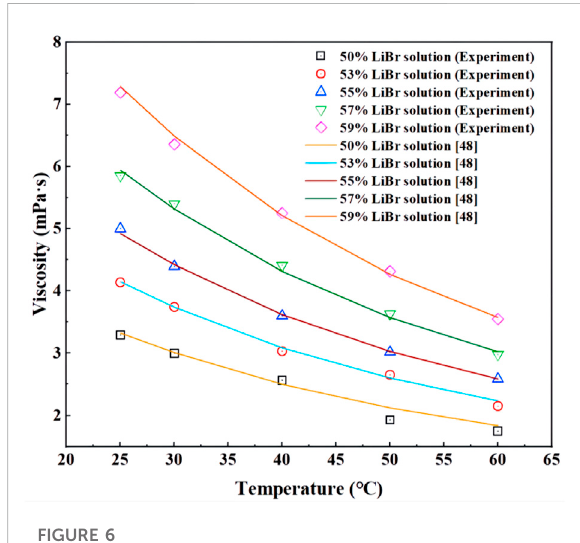
The variation of the viscosity of different concentration LiBr with the